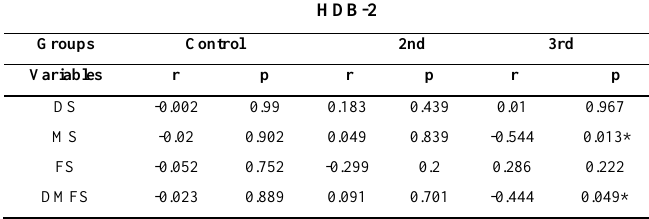
Table 5 : Correlation between caries experience with hDB-2 among groups